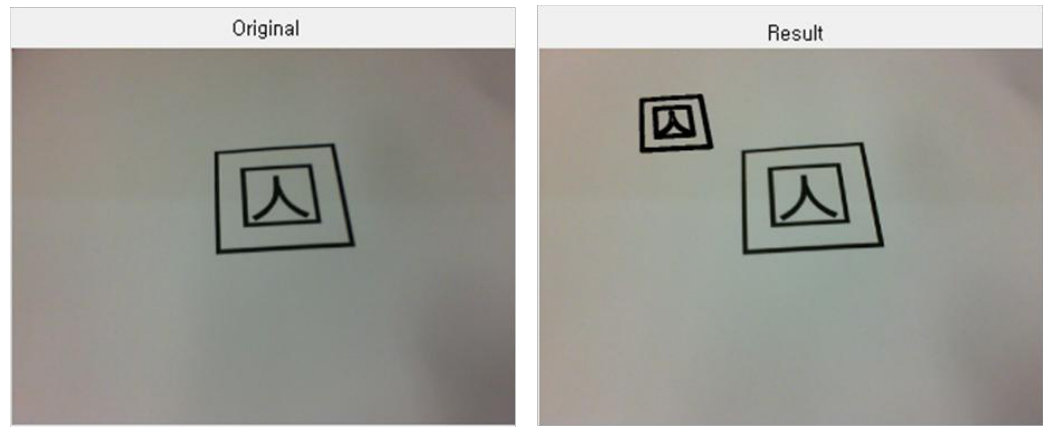
Figure 5. Binarization of the copied and moved